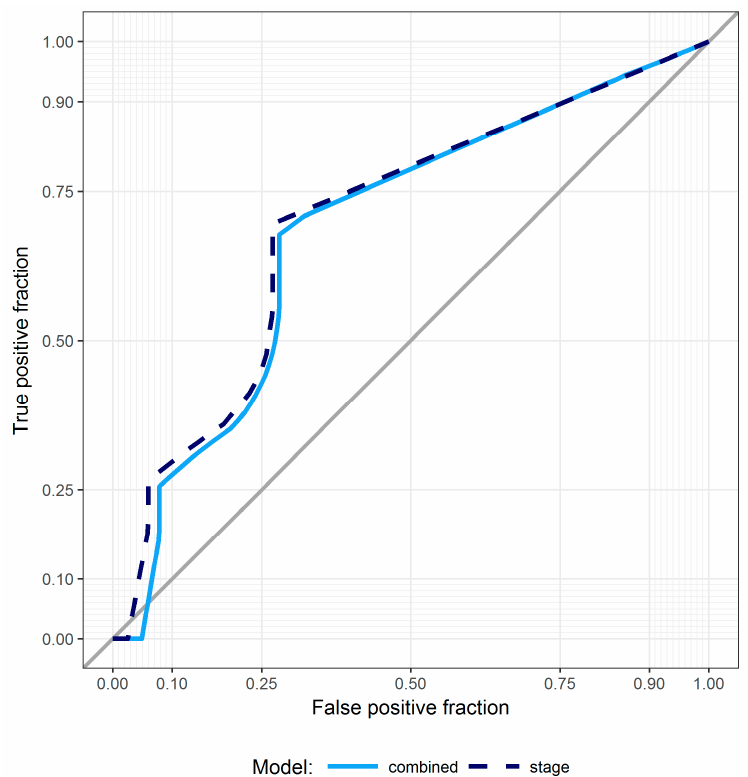
Figure 2. ROC curves for SCC patients. Cross-validated time-dependent ROC curves for the combined (cyan solid line) and stage-only (dashed blue line) models in SCC patients; bisector gray line identifies a purely random discrimination.